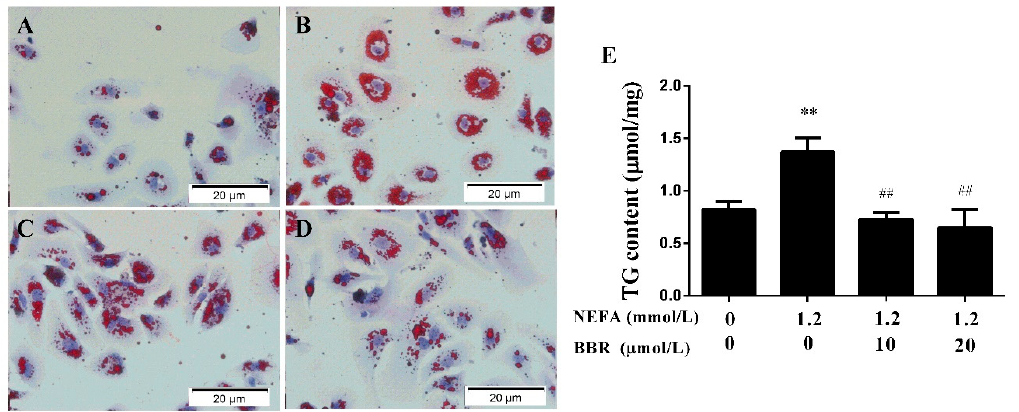
Figure 4. BBR decreased NEFA-induced TG accumulation in bovine hepatocytes. Oil red O staining ( × 40): ( A ) The normal bovine hepatocytes; ( B ) The bovine hepatocytes were pretreated with 1.2 mmol/L NEFA for 9 h; ( C ) After NEFA treatment, the hepatocytes were treated with 10 μ mol/L BBR for another 24 h; ( D ) After NEFA treatment, the hepatocytes were treated with 20 μ mol/L BBR for another 24 h; ( E ) BBR treatment significantly reduced the NEFA-induced increase in TG content. Quantified data are mean ± SD; ** p < 0.01 versus control group; ## p < 0.01 versus NEFA group.